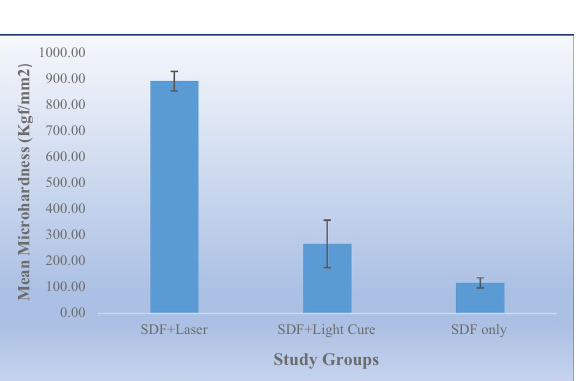
Figure 1. Samples of Pyramidal Indentation for Vickers Surface Hardness Test of Sound Dentin below the Carious Lesion in the Three Study Groups [( a ) Laser + SDF group, ( b ) Light cure + SDF, ( c ) SDF alone].